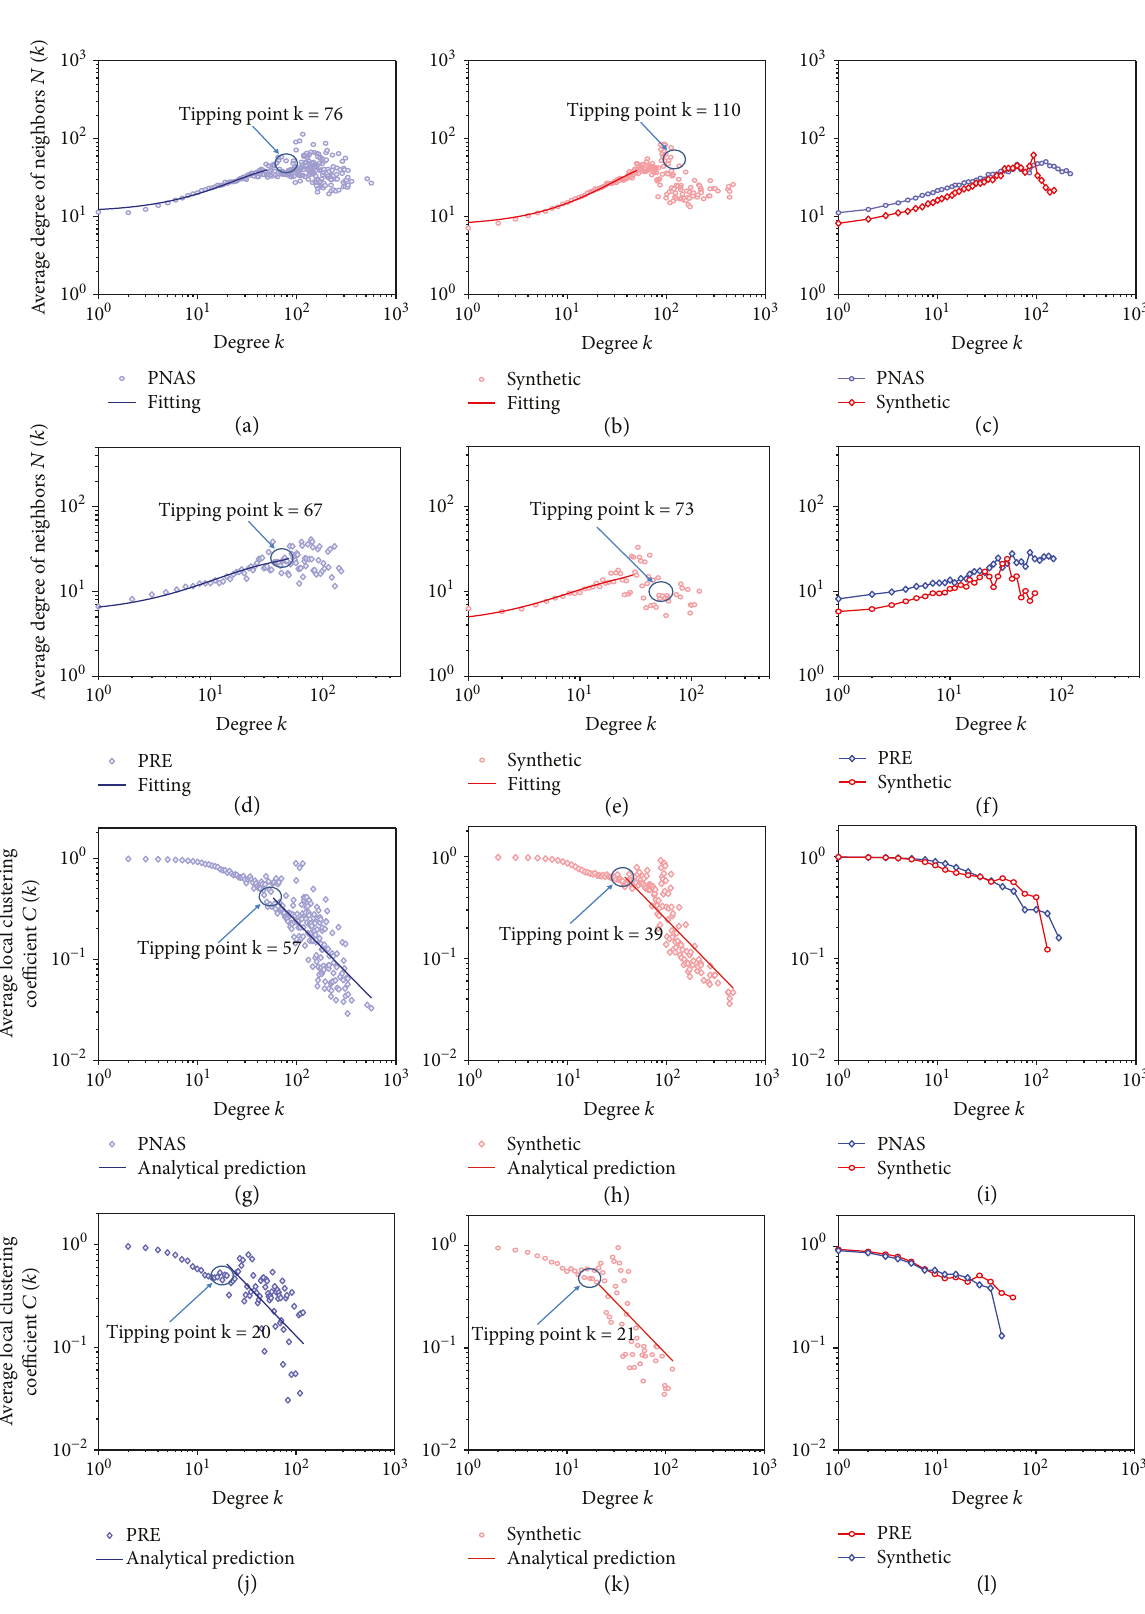
Figure 4: The relation between a degree and an average degree of neighbors and that between local clustering coe ffi cient and degree. The panels show k -degree nodes ’ average degree of their neighbors and their average local clustering coe ffi